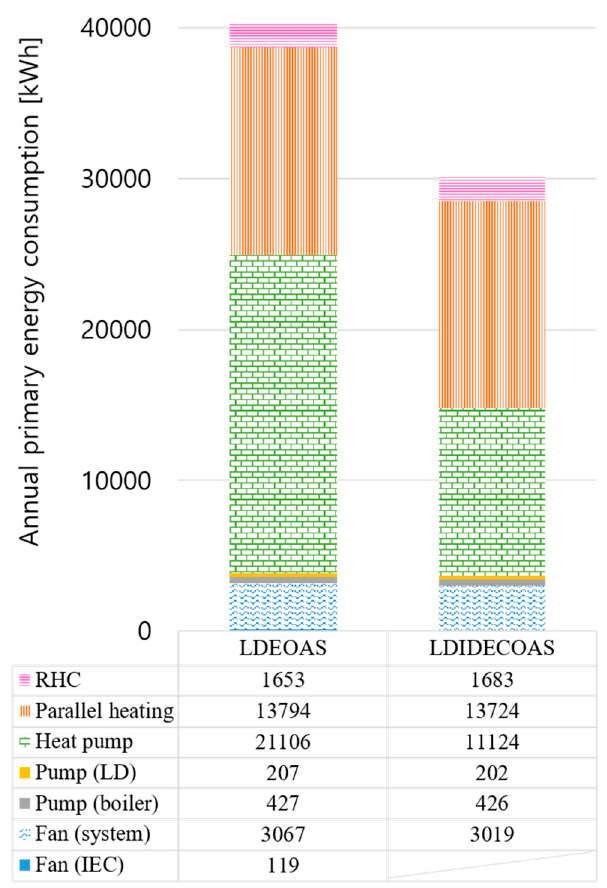
Figure 9. Comparison of annual energy consumption.